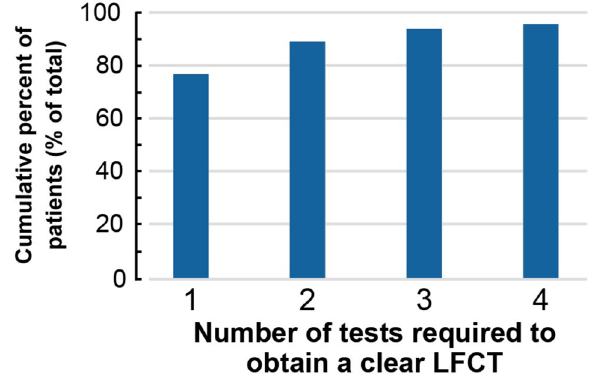
Figure 5. Number of tests required to obtain a clear LFCT. The numbers of tests required to obtain a clear LFCT were shown in Fig. 5. The number of patients in whom we could obtain a clear LFCT value in the first session was 35/46 patients (76.1%), 41/46 patients (89.1%) by the second session, 43/46 patients (93.5%) by the third session, and 44/46 patients (95.7%) by the fourth session. LFCT: lung to finger circulation